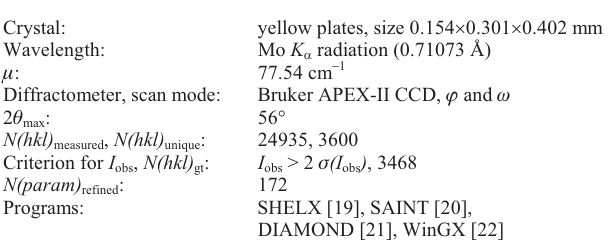
Table 1. Data collection and handling.